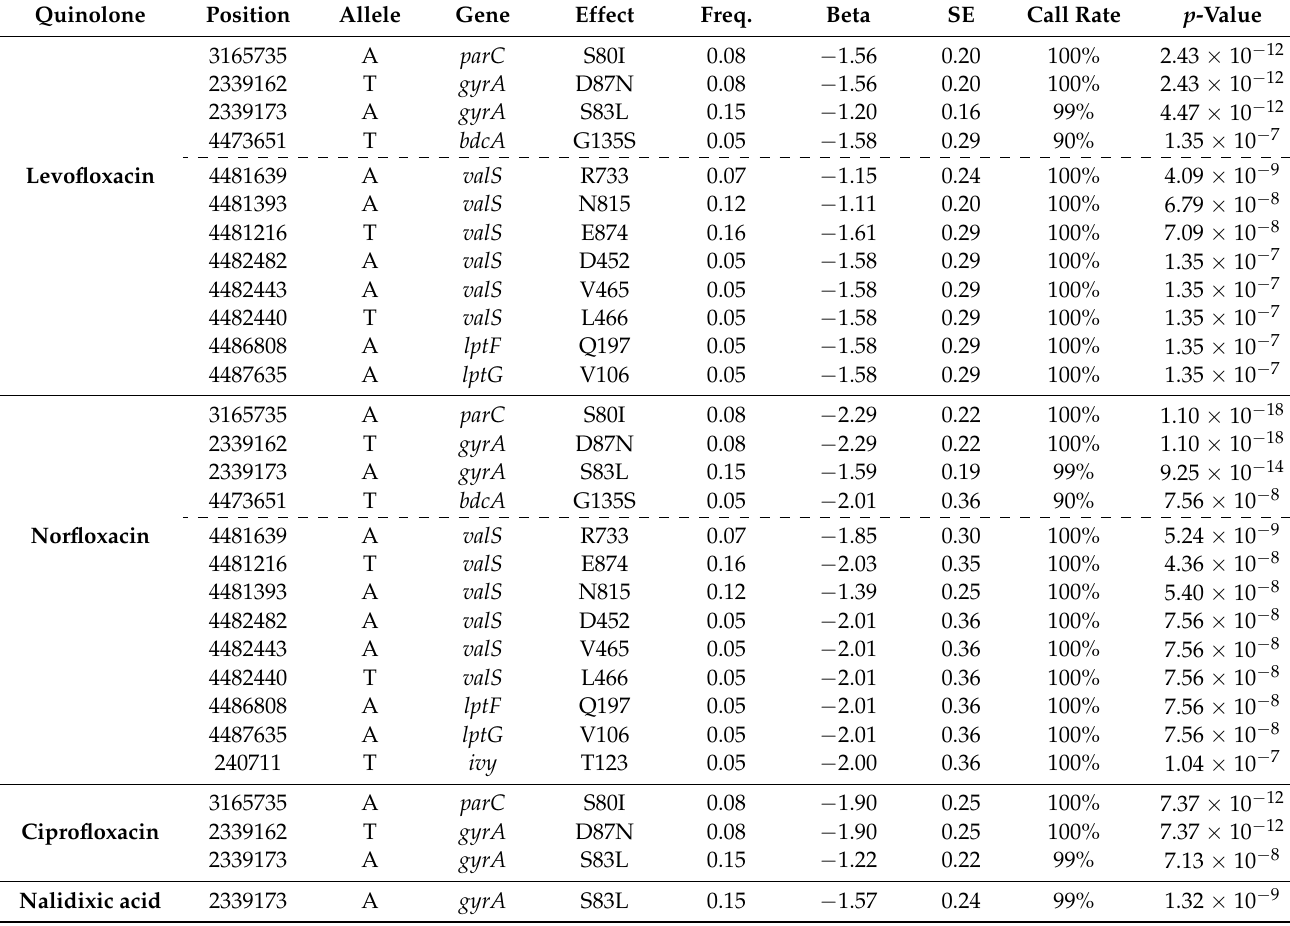
Table 2. Mutations significantly correlating with quinolone resistance. The dotted line separates synonymous and nonsynonymous variants. Freq. is the relative frequency among isolates, beta is the effect size, and SE is the standard error of the fit on beta. Effect size is similar for all, and p -values